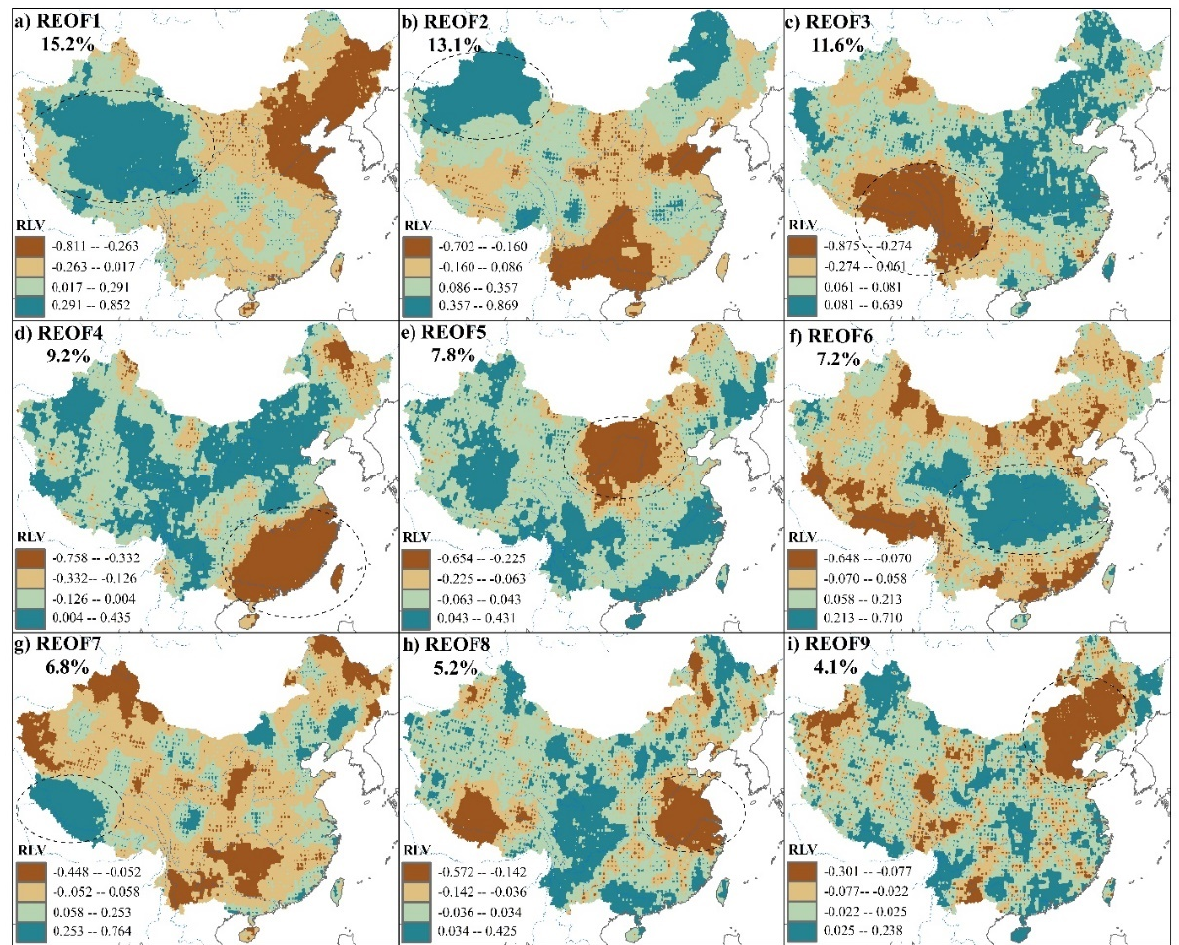
Figure 9. Spatial distribution characteristics of the rotated empirical orthogonal function of the reconstructed scPDSI series over the past two millennia (AD 56–2000).